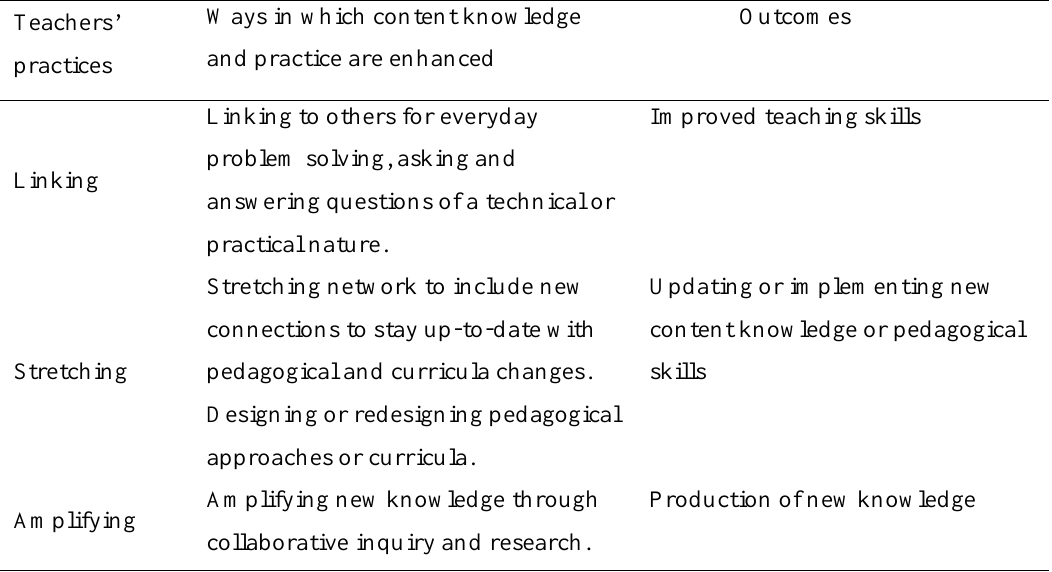
Teachers’ Practices in the Pedagogical